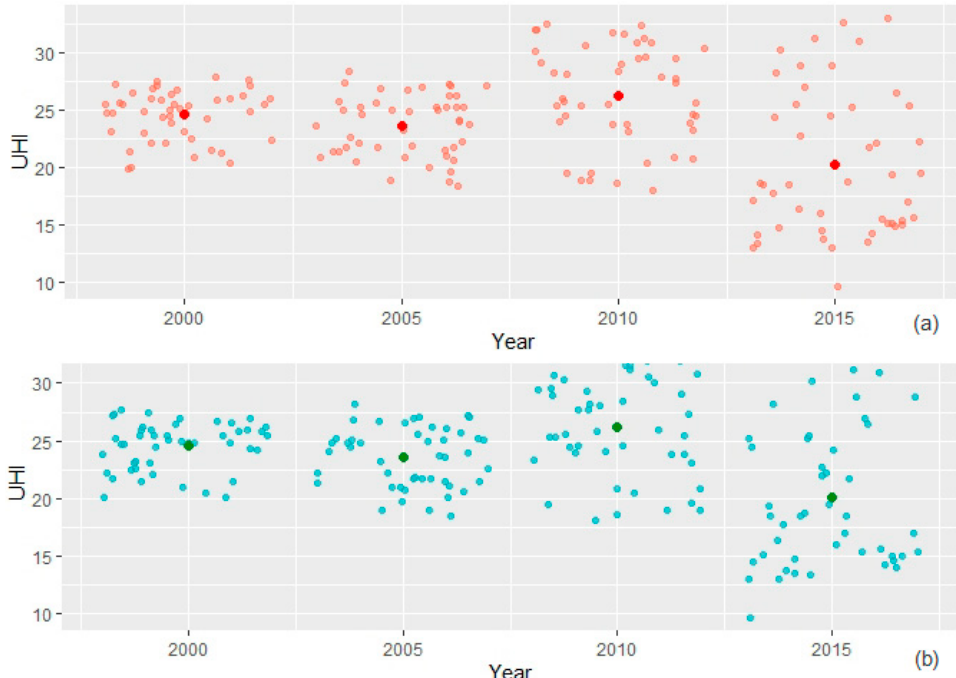
Figure 8. Comparison of the estimation accuracy of the posterior values for the model parameters with different sizes of samples.